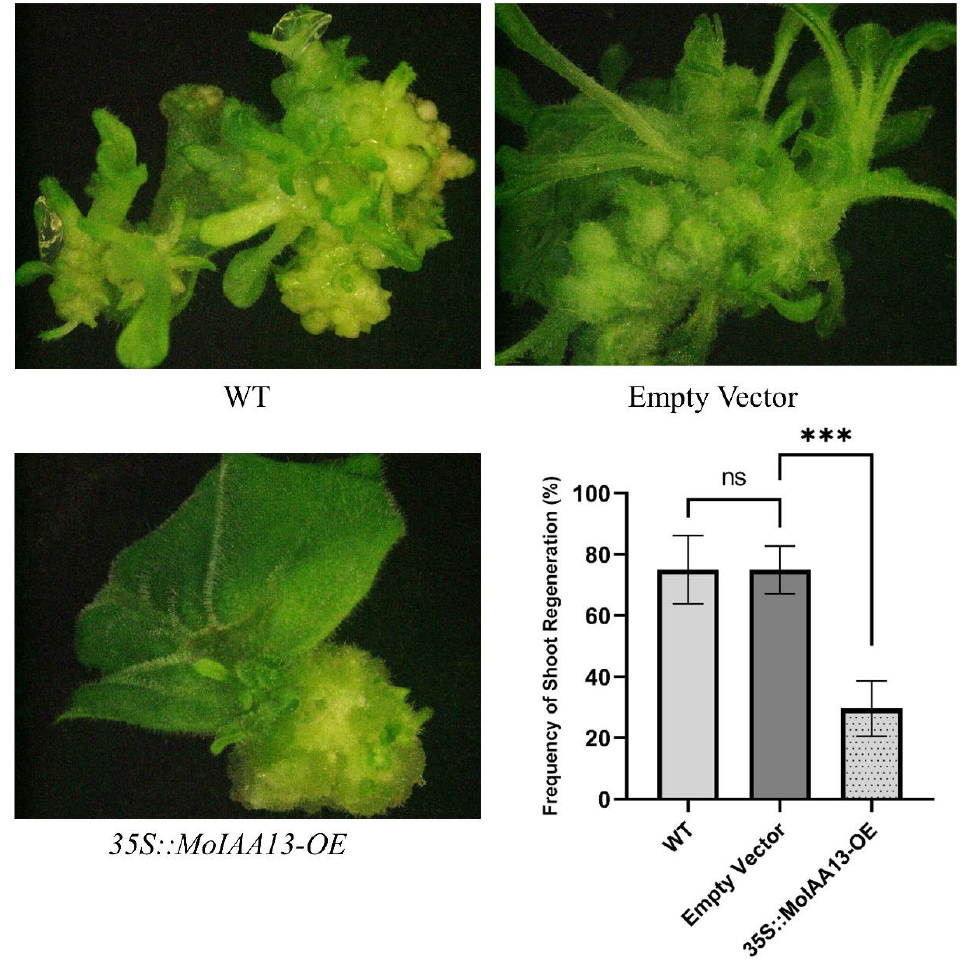
Figure 10. Overexpression MoIAA13 in N. benthamiana compromised the shoot regeneration